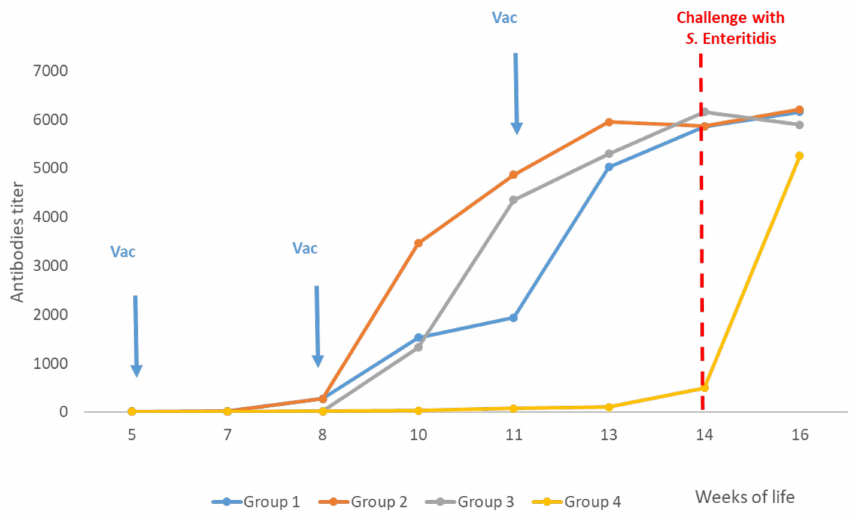
Figure 1. Trial 1—Antibodies titres. Measurements of antibody titres in vaccinated and non- vaccinated chickens. Challenge with S. Enteritidis (SE) was carried out in week 14 of life (red line). Blood samples were taken approximately every 10 days starting at week 5 until week 16 of life (two weeks post-challenge) when all birds were euthanized. Sera were analysed by ELISA (Salm Gp D,